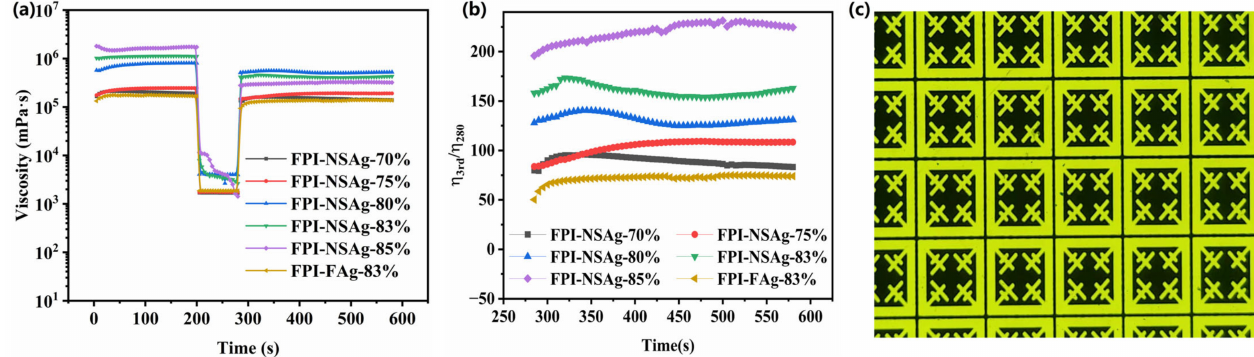
Figure 10. ( a ) The 3ITT curves of silver pastes. ( b ) The viscosity ratio of η 3rd to η 280s of silver pastes. ( c ) The micrograph of the conductive microstructure of FPI-NSAg-83% paste silk-screened on PI